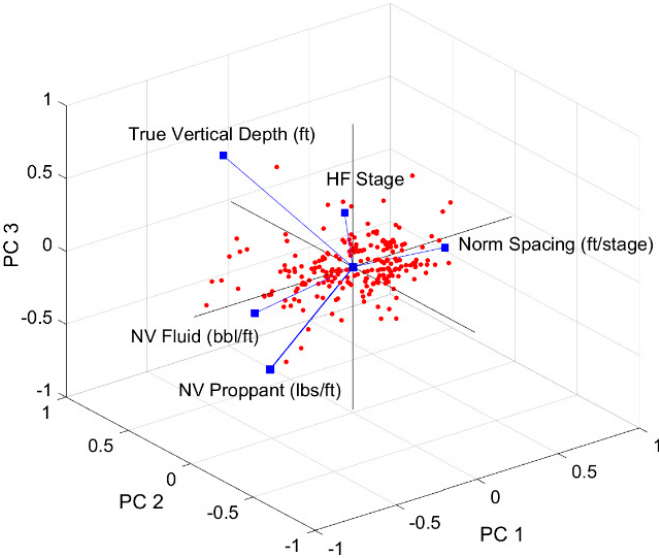
Figure 9. Scree plot of PCA results for all cases: ( a ) Case 1; ( b ) Case 2; ( c ) Case 3; ( d ) Case 4.